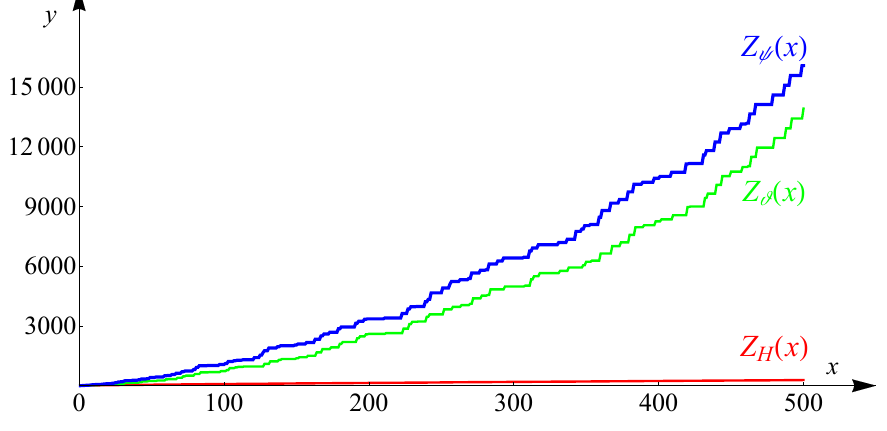
Figure 1. The graphs of the functions Z H ( x ) , Z ϑ ( x ) and Z ψ ( x ) for x ∈ ( 0, 500 ]